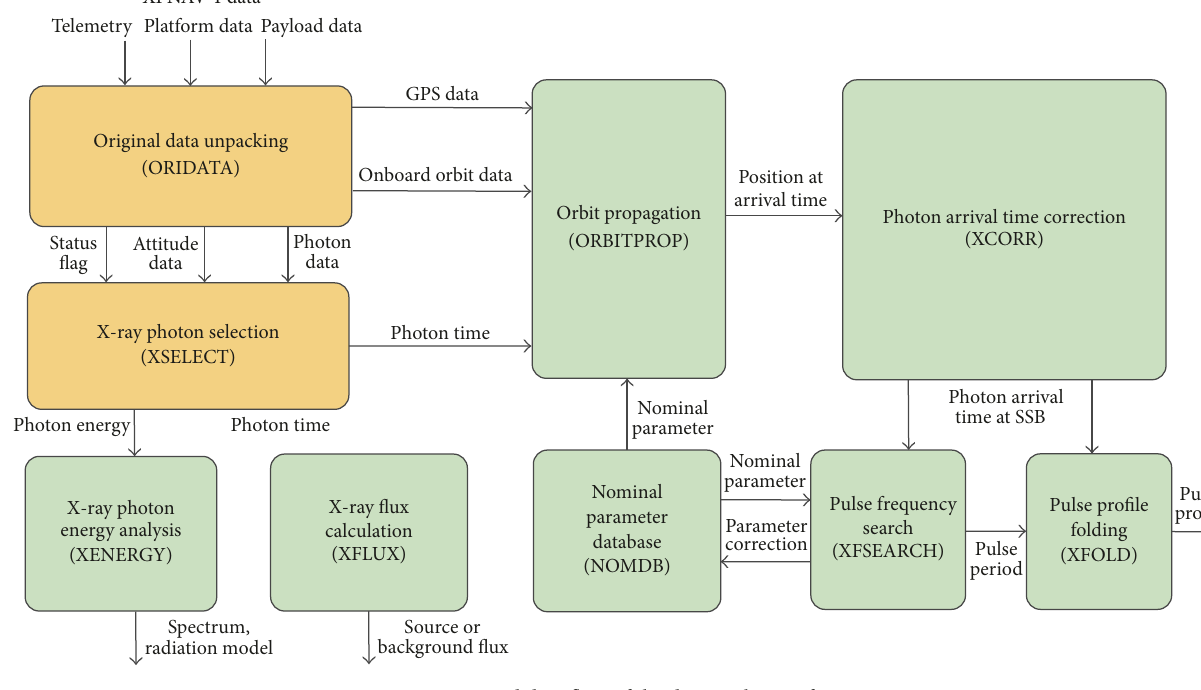
Figure 3: Structure and data flow of the data analysis software system.